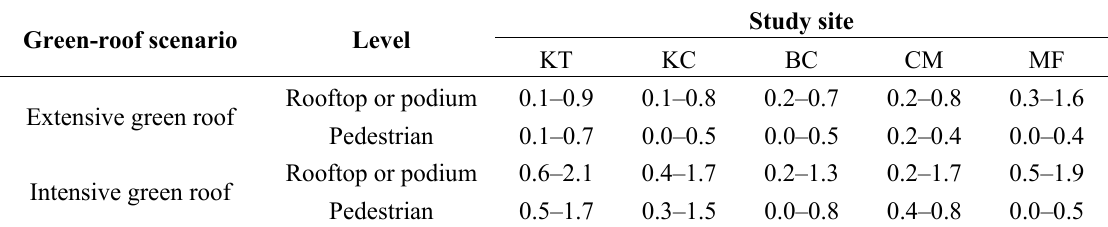
Table 4. Horizontal ranges of cooling effects (°C) for two green roof types and two levels in five study